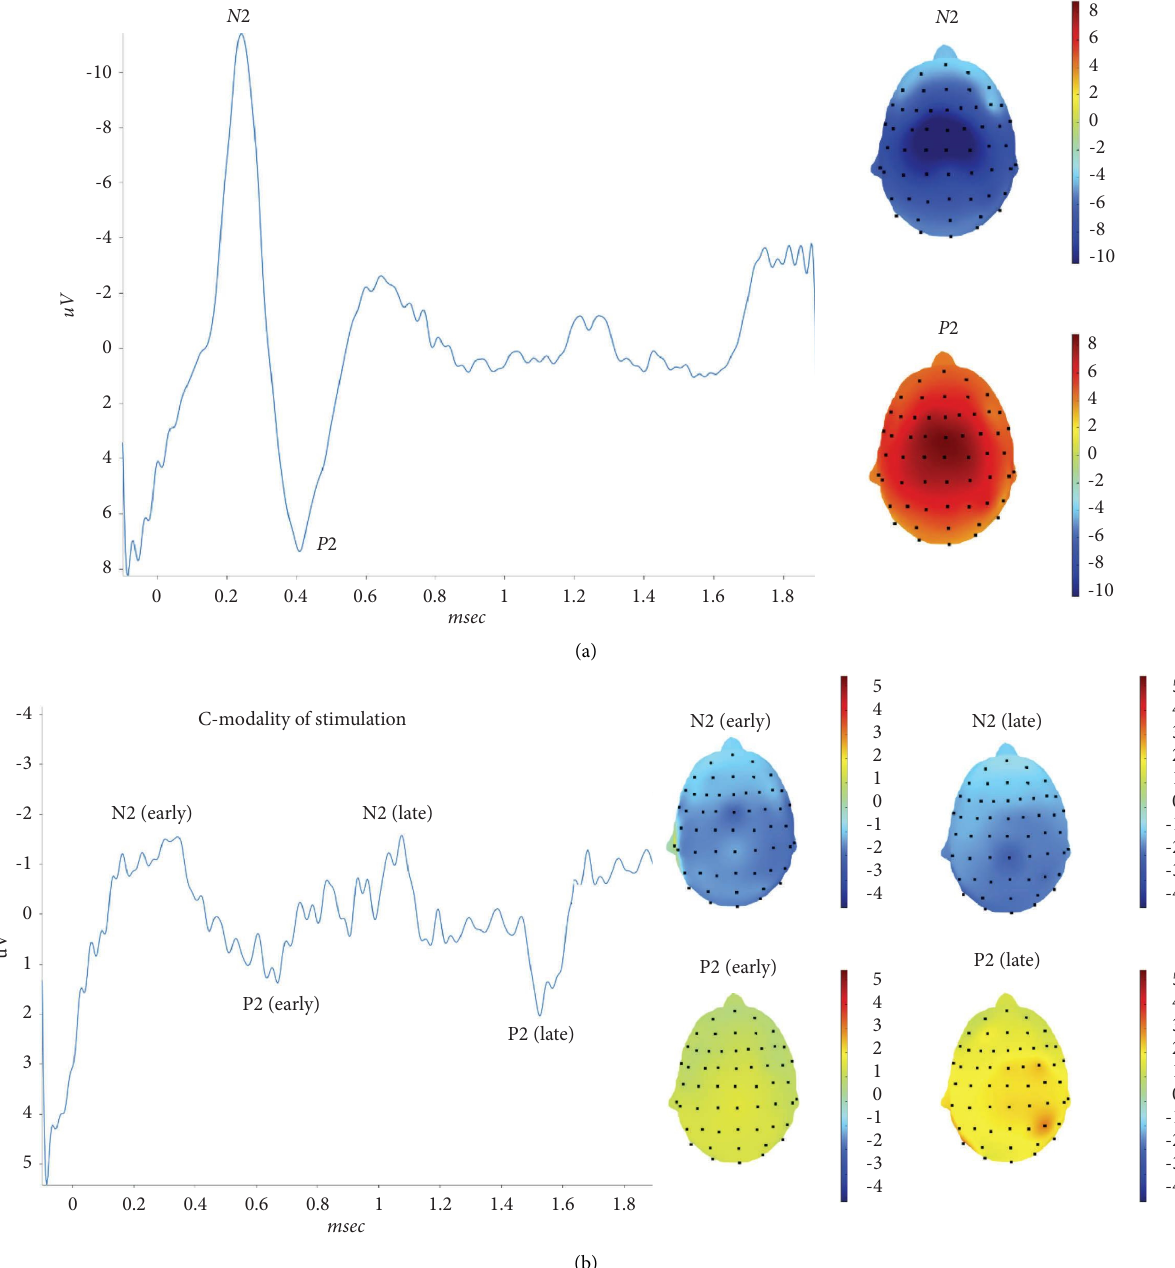
Figure 5: On the left side, the grand average of N2 P2 waves was obtained by right foot stimulation. On the right side, the corresponding topographical maps are represented. Te grand average in the lower part of the fgure, for the C-modality of stimulation, shows to distinct (early and late) negative/positive complexes. Te topographical maps refer to the recorded N2-P2 waves. Upper: a-delta modality of stimulation. Lower: C-modality of